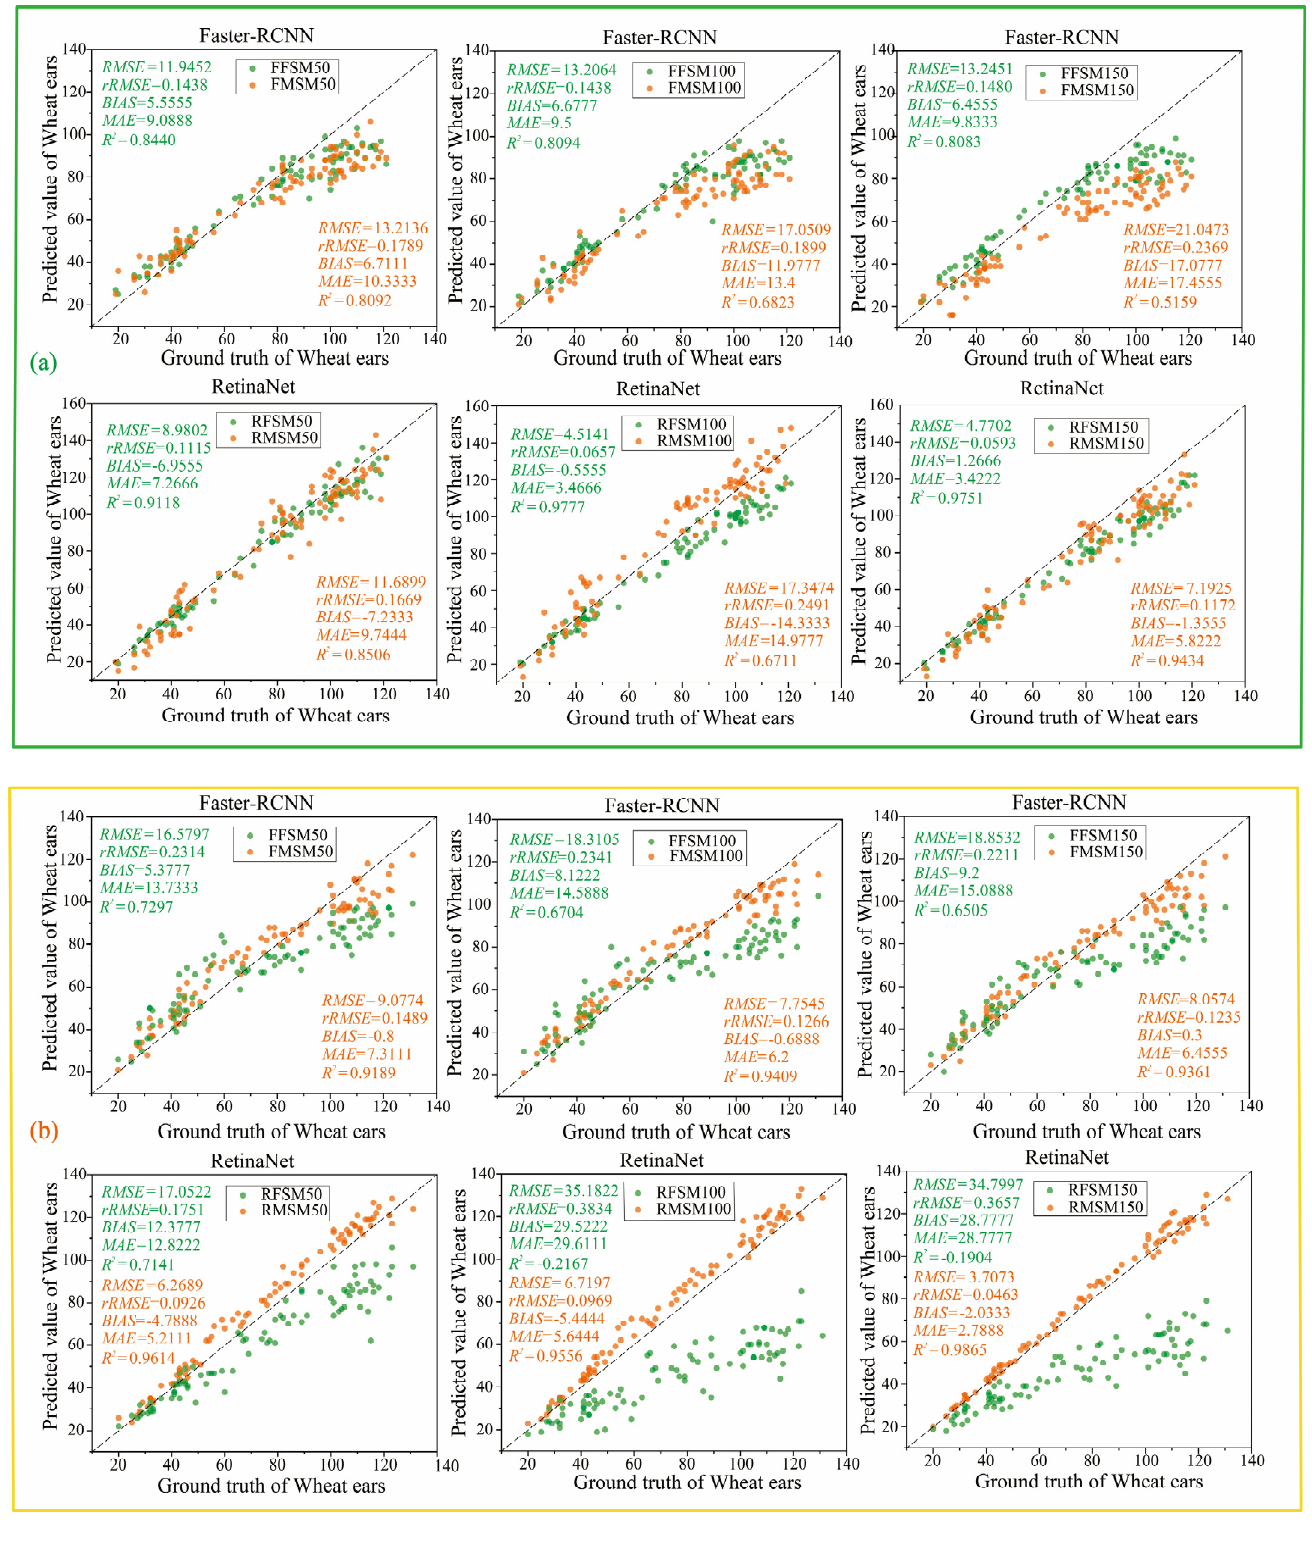
Figure 10. The performance of the models after transfer learning on the test data set with images collected in ( a ) filling stage; ( b ) mature stage.